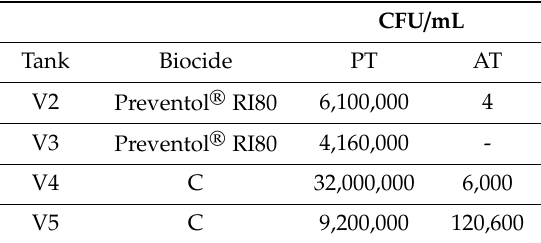
Table 7. Evaluation of the biocidal activity of Preventol ® RI80 and cinnamon essential oil (C) through microbiological analyses. (PT: pretreatment, AT: after